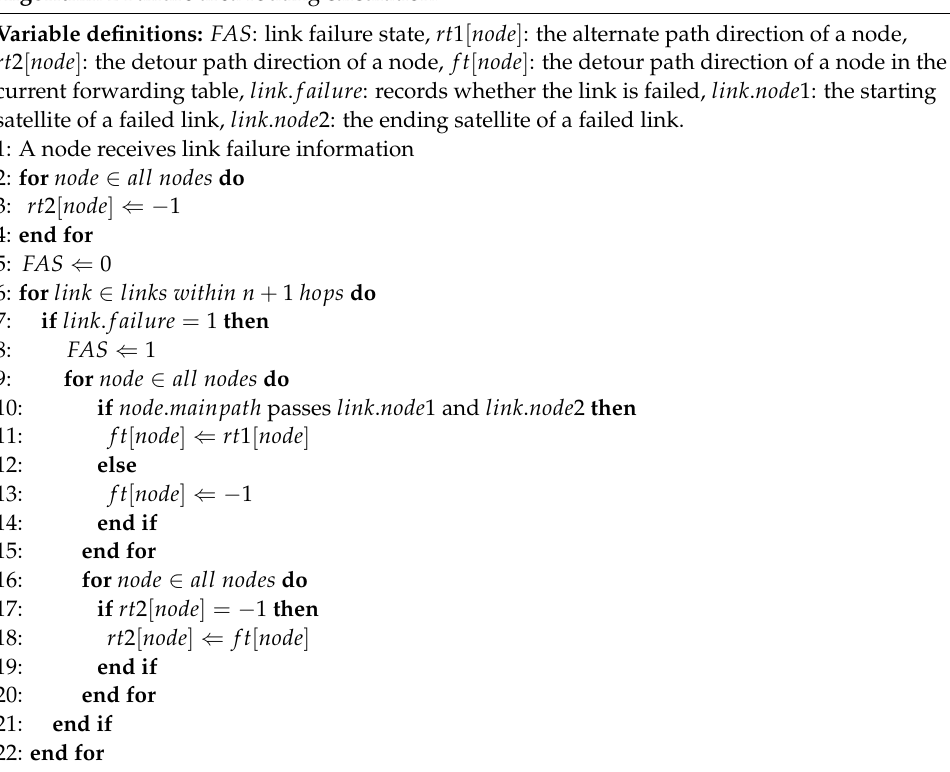
Algorithm 2 Failure area routing